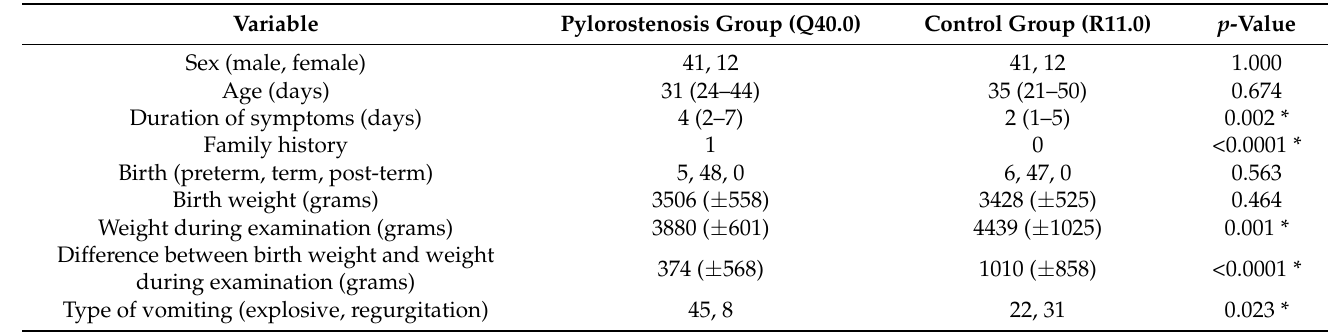
Table 1. Differences between Q40.0 and R11.0 groups.